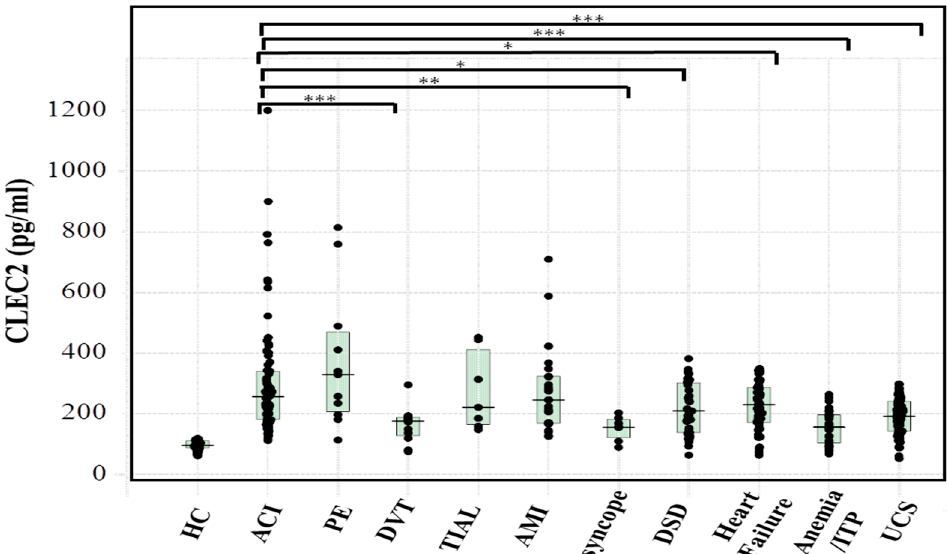
Figure 1. The plasma sCLEC-2 levels in various diseases. HC ( n = 70), healthy control; ACI, acute cerebral infarction; PE, pulmonary embolism; DVT, deep vein thrombosis; TIAL, transient ischemic symptoms for cerebral infarction within 24 h; AMI, acute myocardial infarction; DSD, digestive system disease; ITP, idiopathic thrombocytopenic purpura; UCS, indefinite compliant syndrome; *** p < 0.001; ** p < 0,01; * p < 0.05.